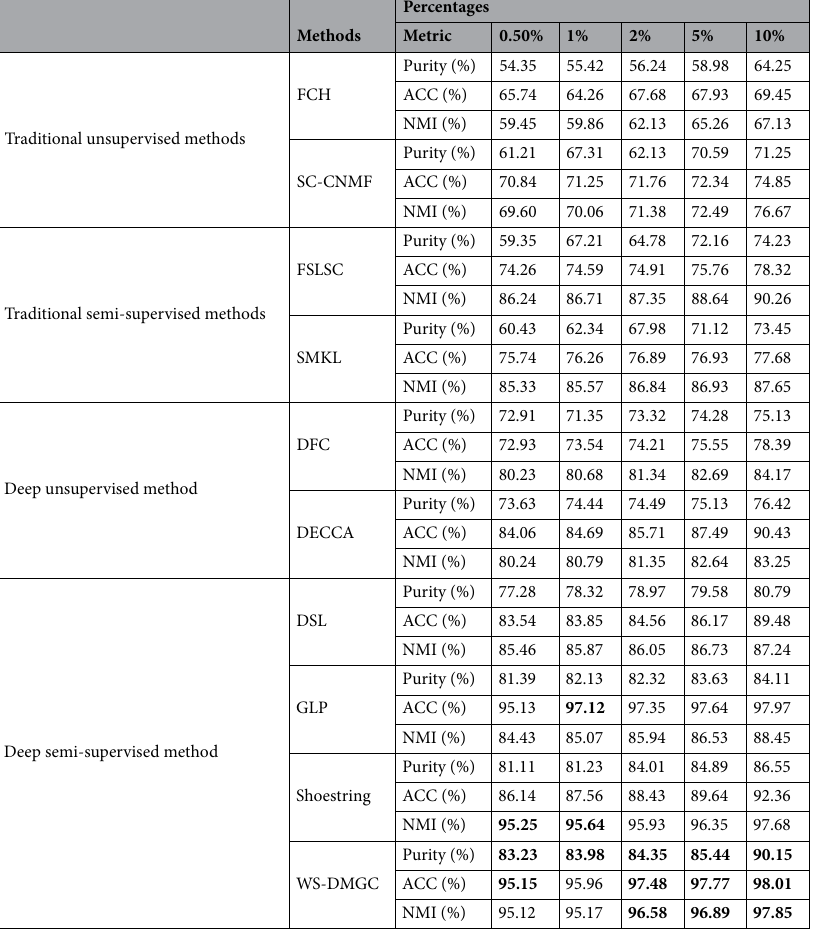
Table 4. Comparison results in terms of three metrics (purity, ACC and NMI) on TCIA